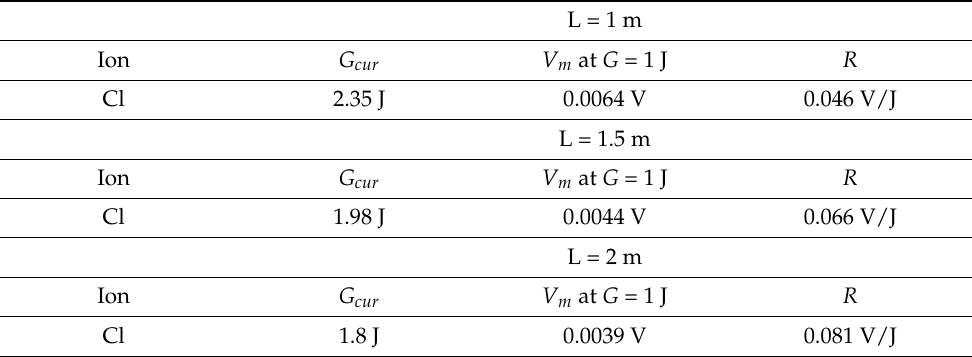
Table 1. The table represents the curving energy point, the membrane potential at G = 1 J, and the average rate of depolarization at different values of gate length L and according to the other setting values in Figure